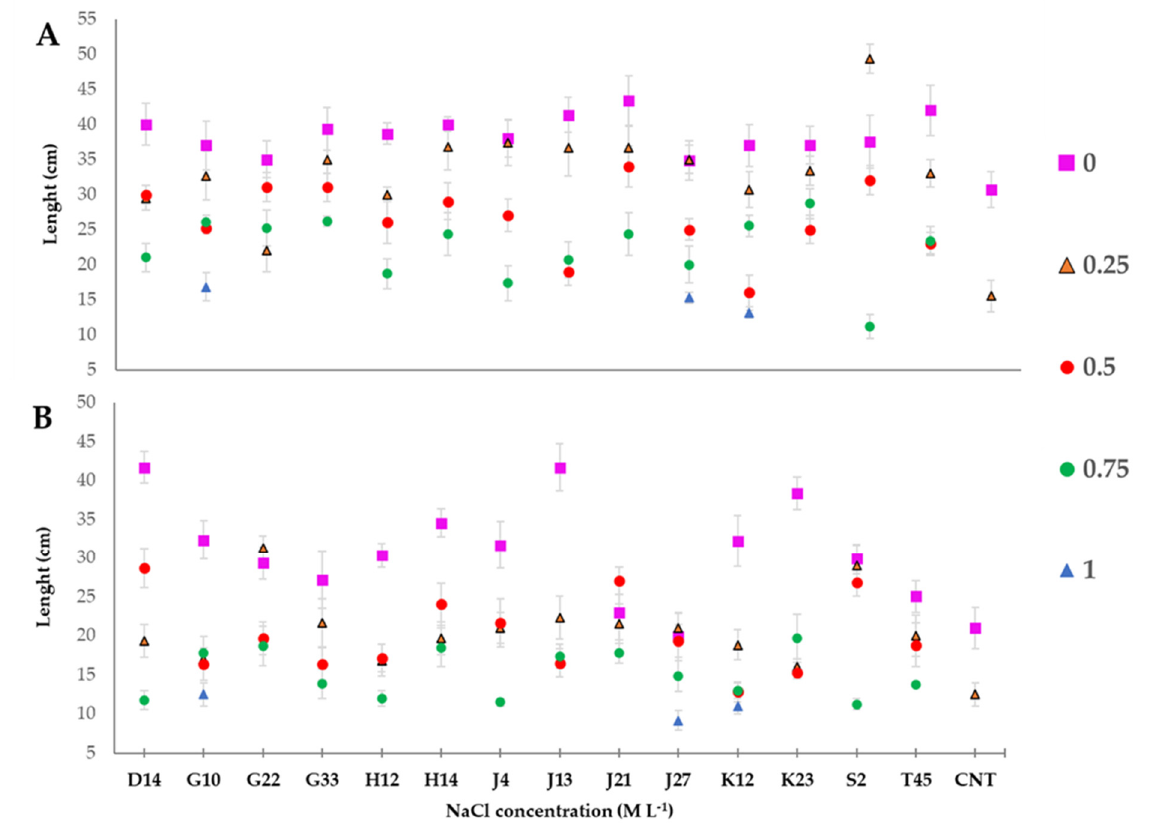
Figure 3. Shoot ( A ) and root ( B ) length of inoculated and uninoculated plants grown without (0 M NaCl) and with NaCl in the soils (0.25 M, 0.5 M, 0.75 M, 1 M NaCl) (n = 3).